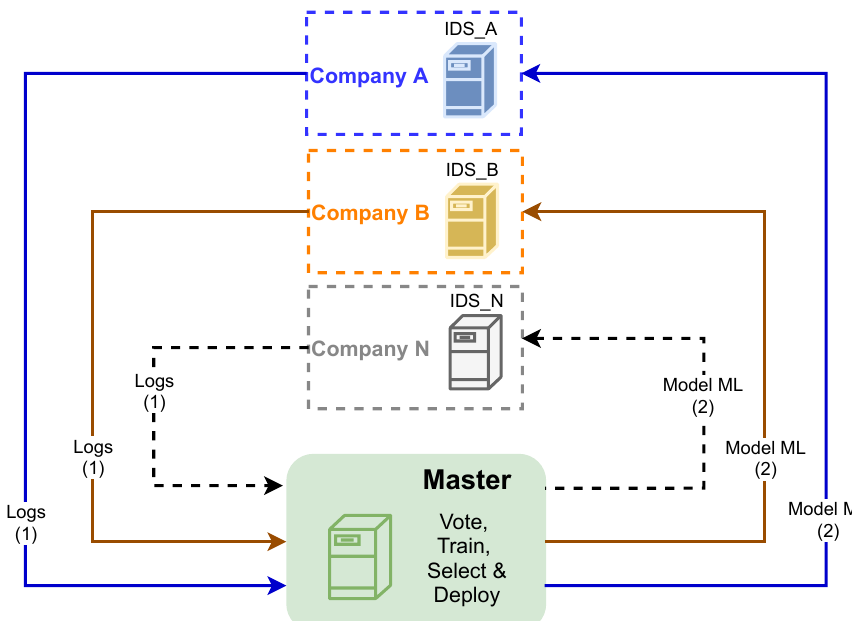
Figure 1. Proposed